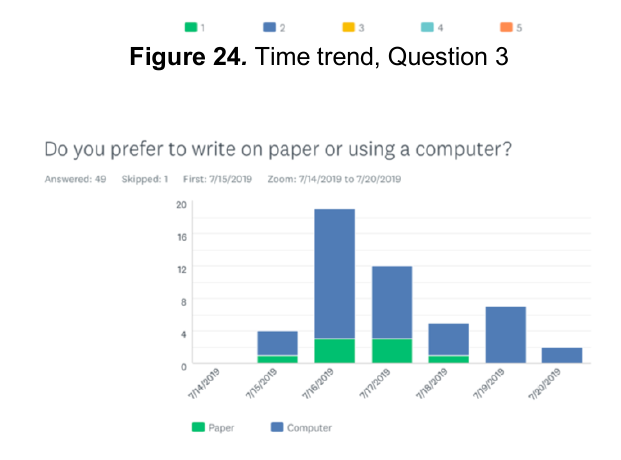
Figure 25 . Time trend, Question 4